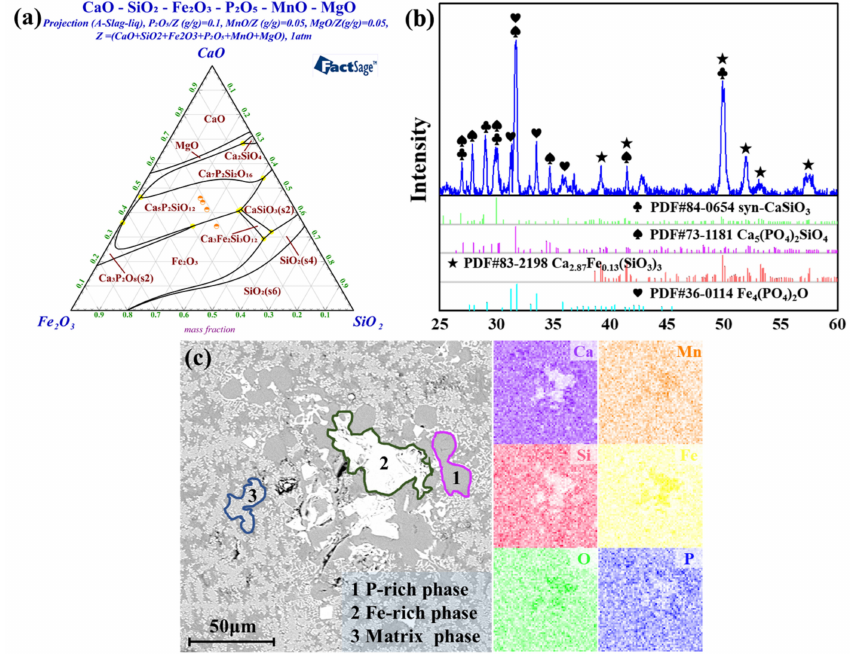
Figure 2. Phases of high phosphorus steel slag ( a ) phase diagram containing the composition of experimental slag ( b ) XRD patterns and ( c ) SEM and EDS